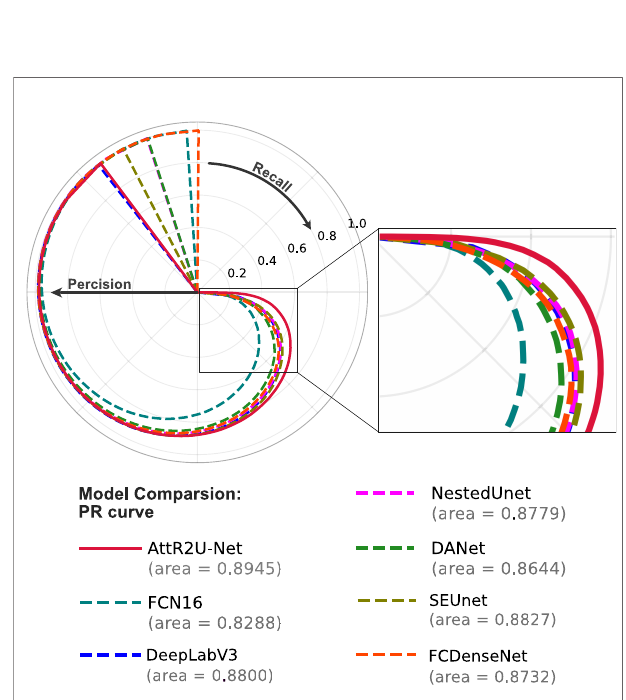
FIGURE 9 | The PR curve of model comparison on the nasopharyngeal carcinoma segmentation test set. The area value indicates the AUC value of each PR curve, and it can be seen that the AttR2U-Net model has the highest AUC value and is located at the outermost